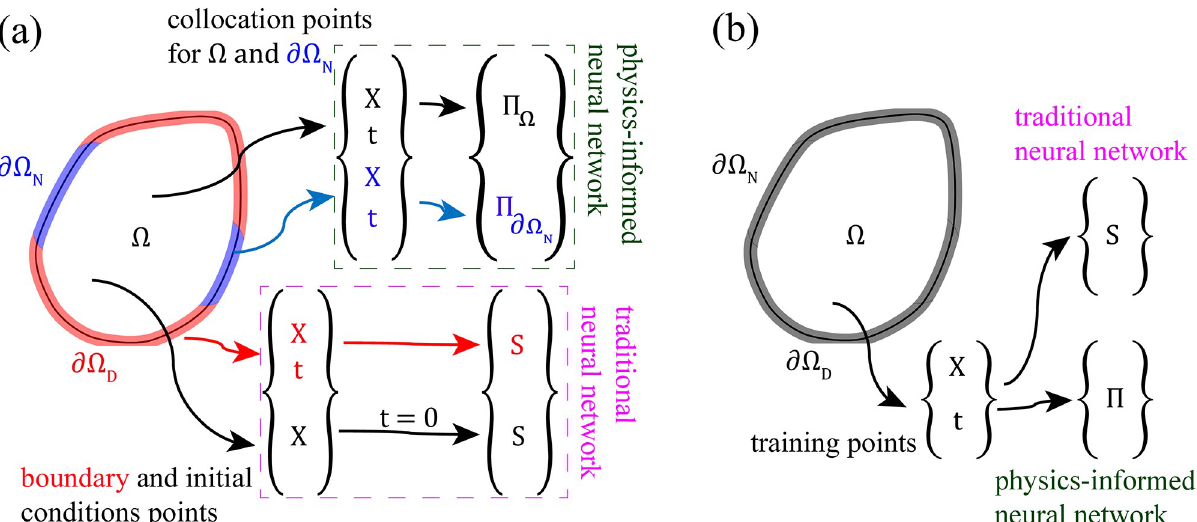
Fig 2. Illustration of the parts of input space used for training the PINN. (a) forward model and (b) inverse model. The collocation ( O � T ), boundary and initial points ( @ O � T and O at t = 0) are utilized in the forward model. However, only the training points ( O � T ) are employed in the D inverse model. X represents a set of spatial coordinates ( x , y , and z ), t is a set of coordinates in the time domain, and S is a set of solution values ( u and p ) corresponding to X and t